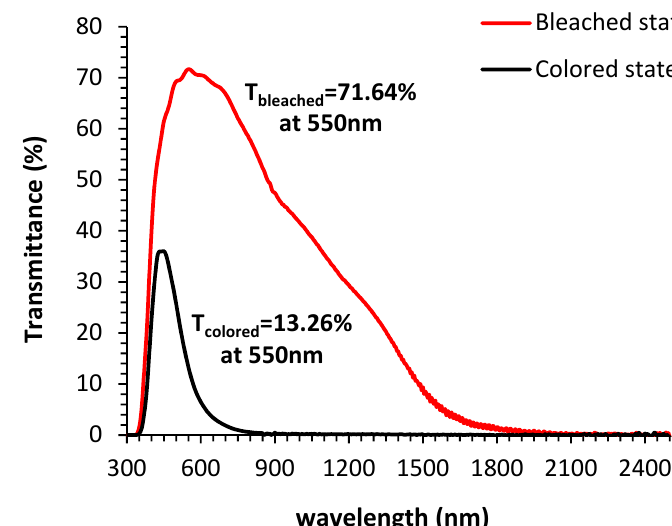
Figure 10. Transmittance of fabricated electrochromic cell at the colored state and the bleached state. Figure 11 represents the variation of charge inserted to and extracted from the electrochromic device during the coloration and bleaching process respectively.